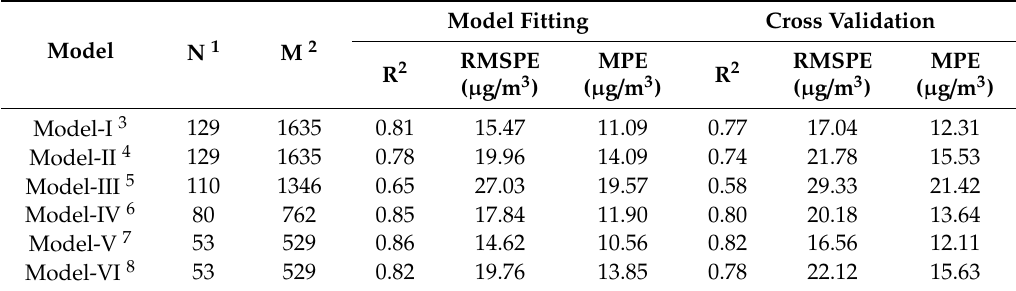
Figure 3. Scatterplots for model fitting and cross validation between estimated and measured PM 2.5 for each year. ( a ) Model fitting; ( b ) model cross validation. The red solid line represents the regression line and the green dashed line is the 1:1 line with slope of 1.0; ‘I’ denotes models using PM 2.5 24 ‐ hour average, and ‘II’ denotes models using PM 2.5 time average of 10:00 and 14:00.